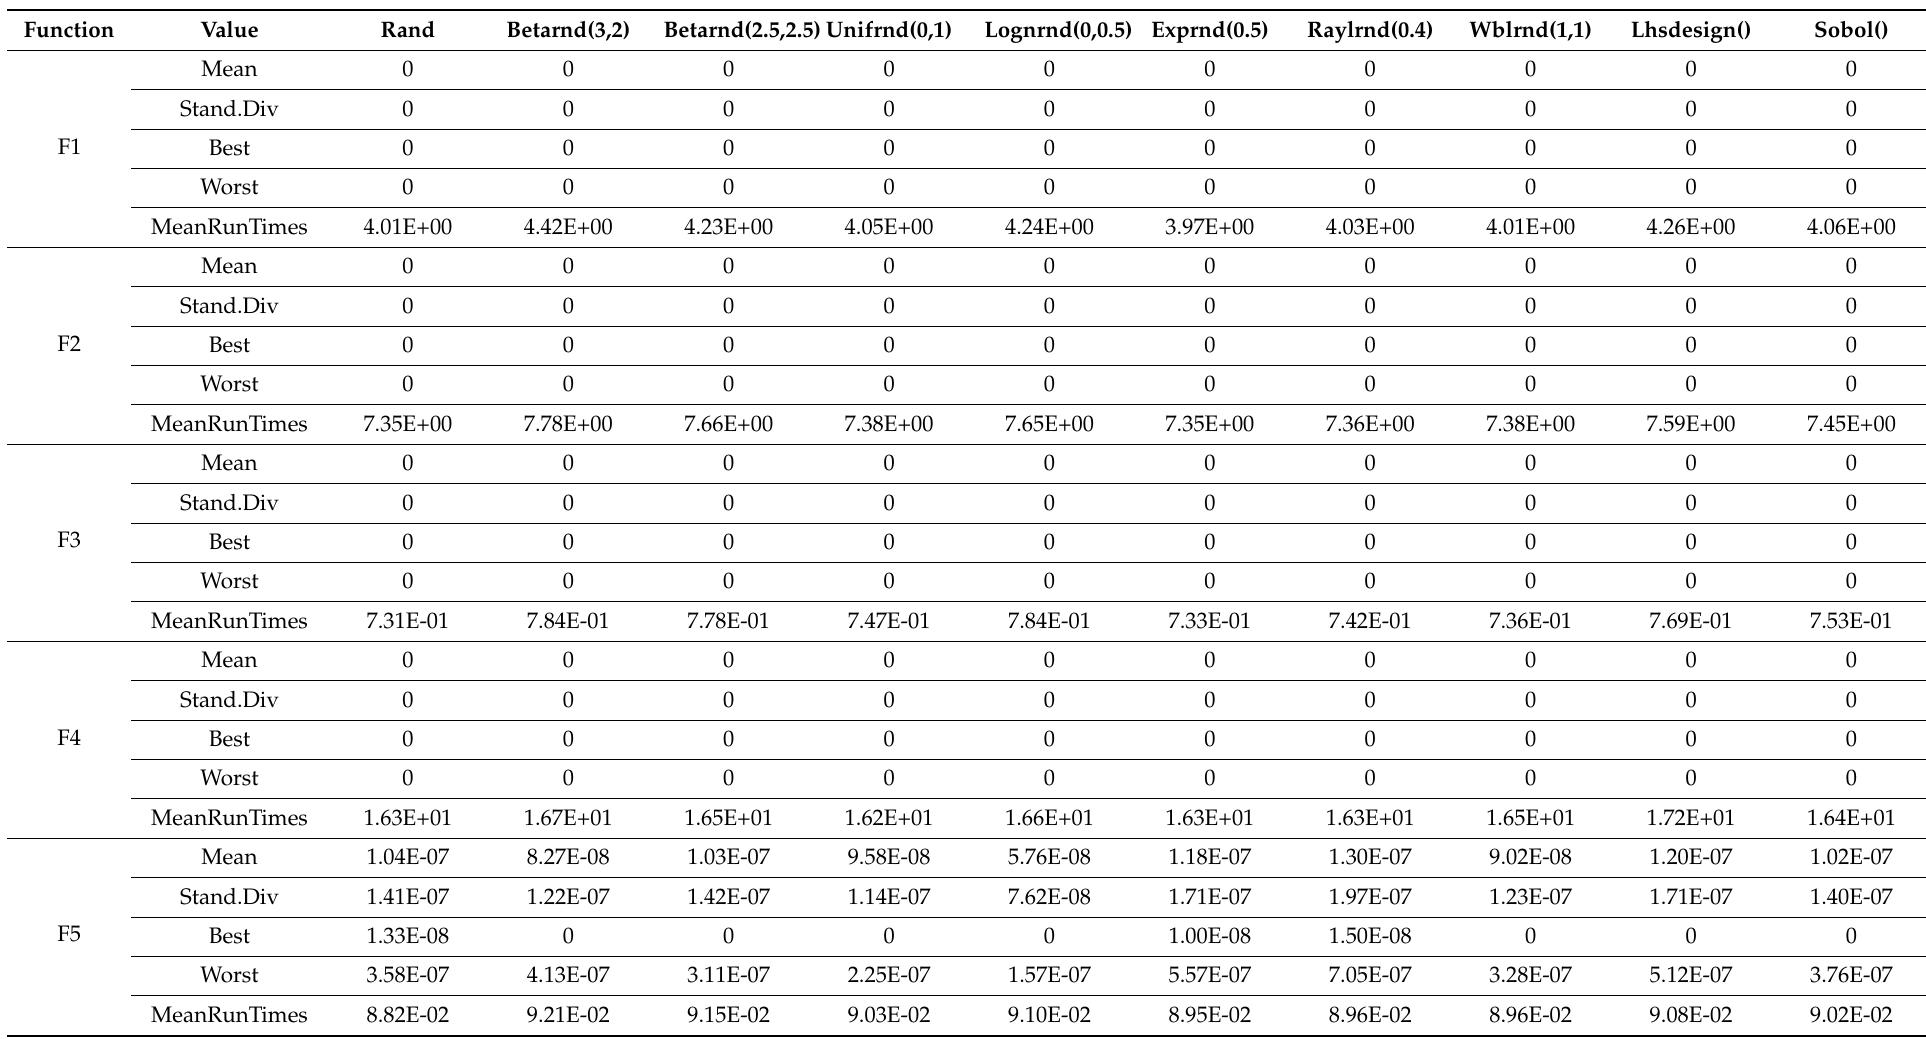
Table 18. Results for